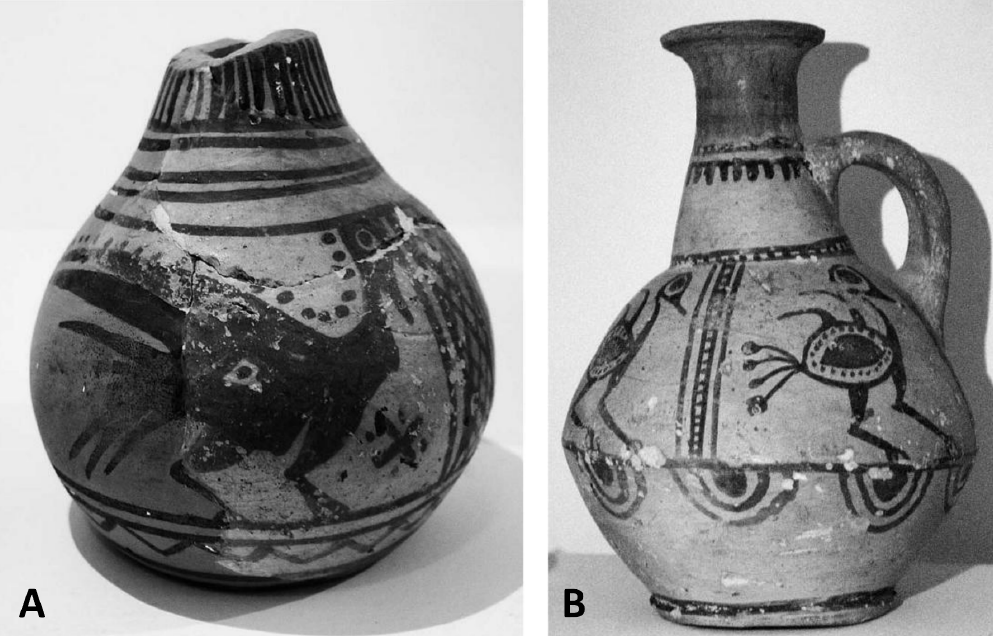
Figure 5 Examples of Qurayyah ware: A. Jar from the sanctuary area of Timna; B. Jar from unknown location in Southern Jordan (Photos from Tebes 2014, 168,